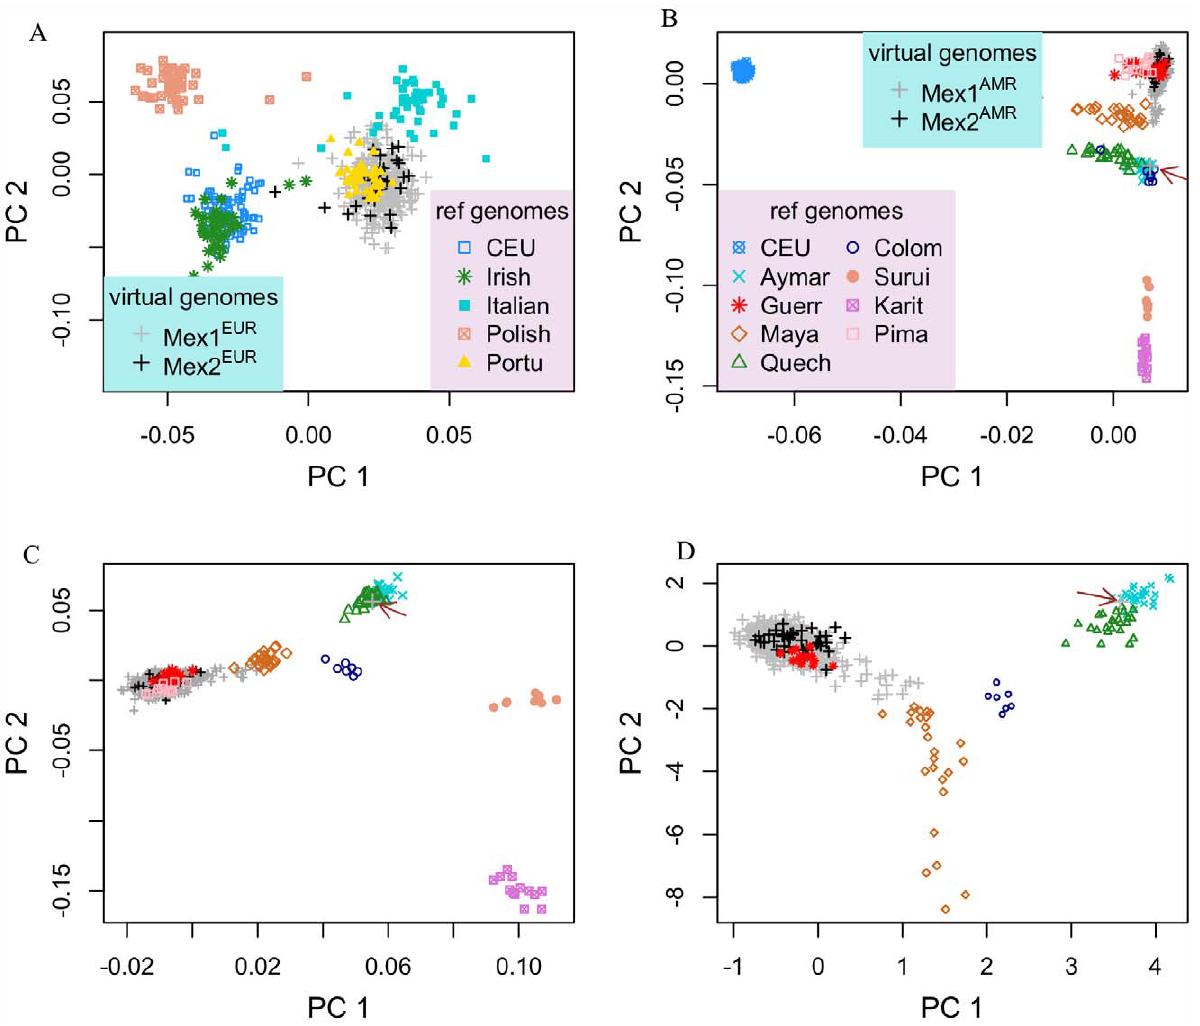
Figure 3. Population structure within the European and Indigenous American components of Mexican genomes. (A) Principal component analysis of the European chromosomal segments traces the ancestry origin closest to Portuguese. (B) Principal component analysis of Indigenous American segments, HapMap CEU and various Indigenous American populations. (C) Same as (B), with CEU individuals removed. (D) Same as (B), with CEU, Surui, Karitiana and Pima removed. The arrow highlights a Mexican individual whose ancestry is traced to the South American group of Aymara.